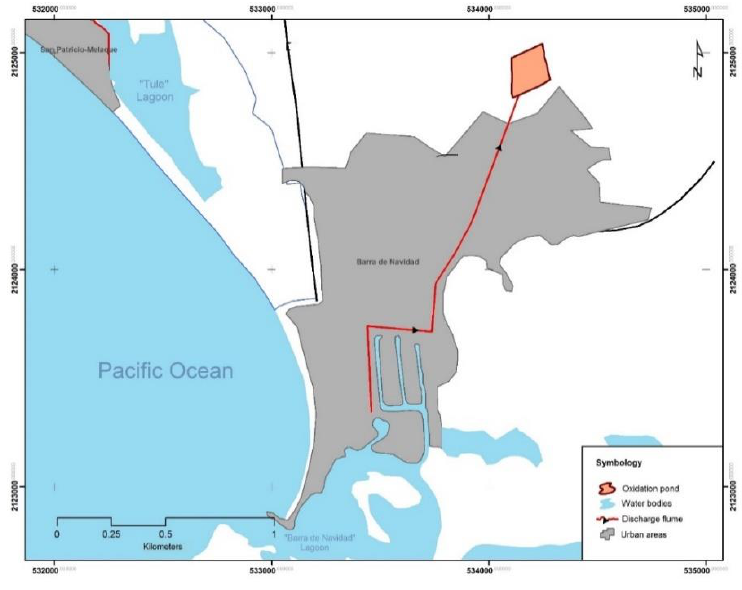
Figure 5. Location of "L" effluent.